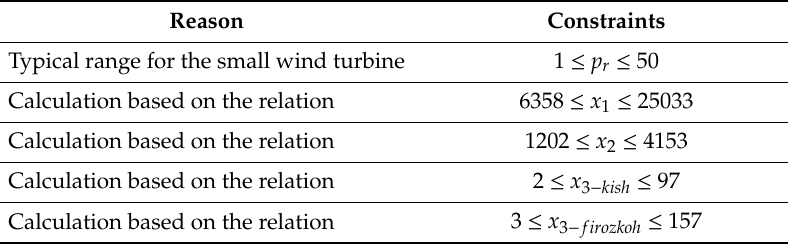
Table 5. Range of variation for the decision variable.